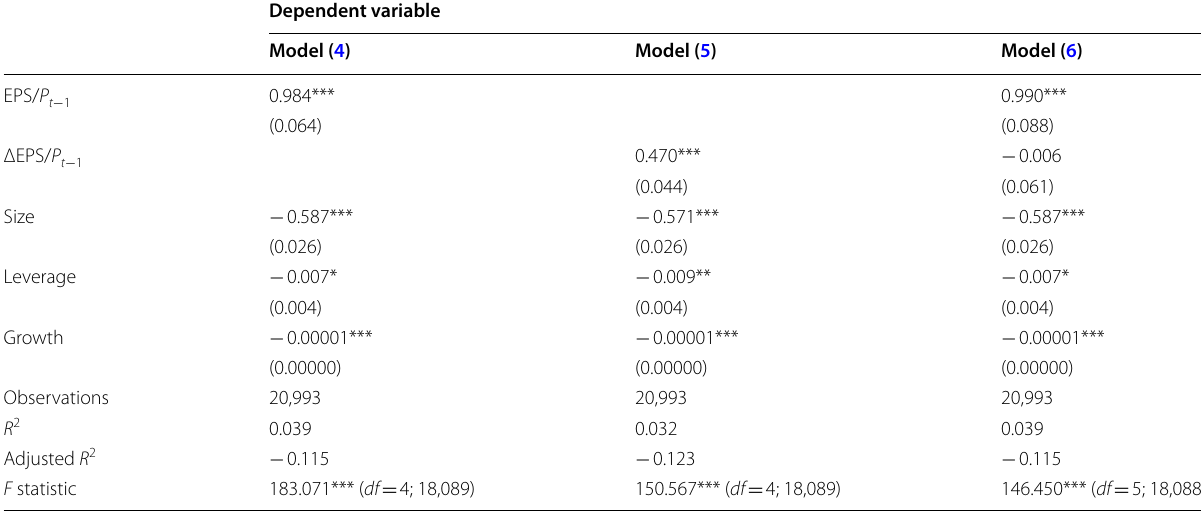
Table 7 Regression results using control